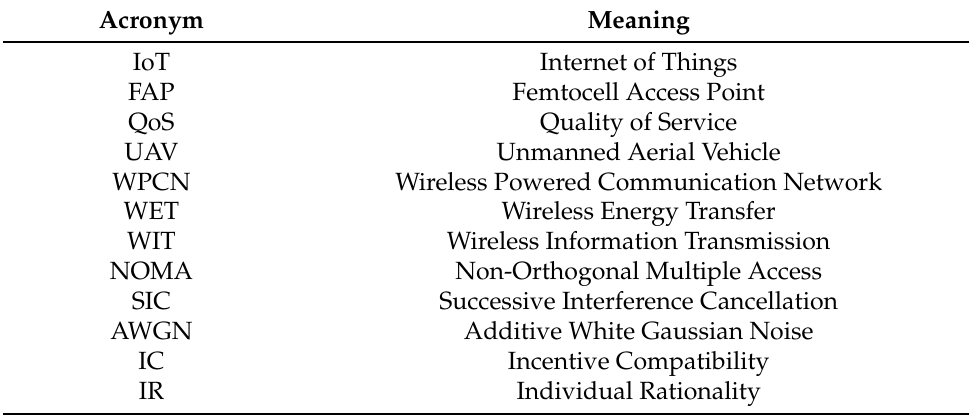
Figure 1. Smart Energy Harvesting for Internet of Things Networks. Table 1. List of